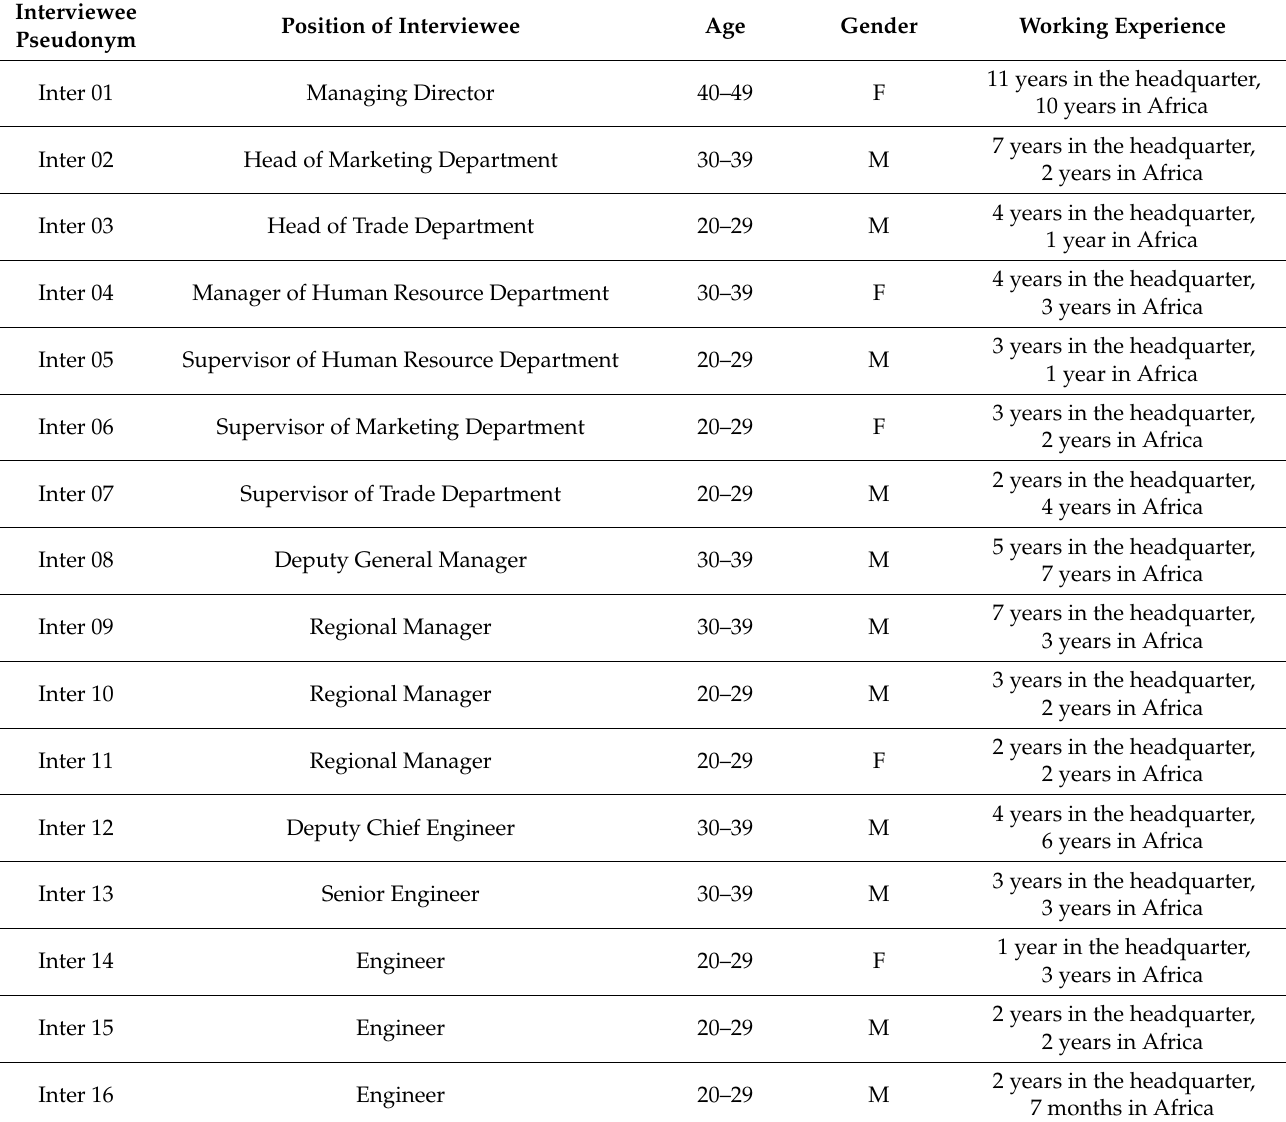
Table 2. Profile of the